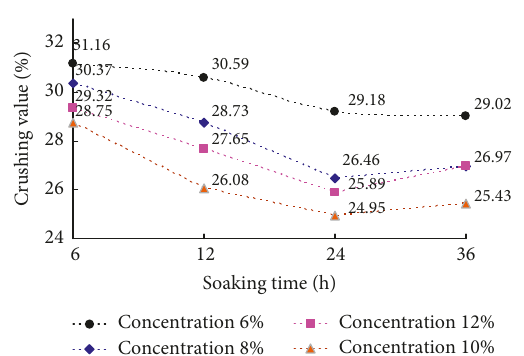
Figure 13: Crushing value of SRC.